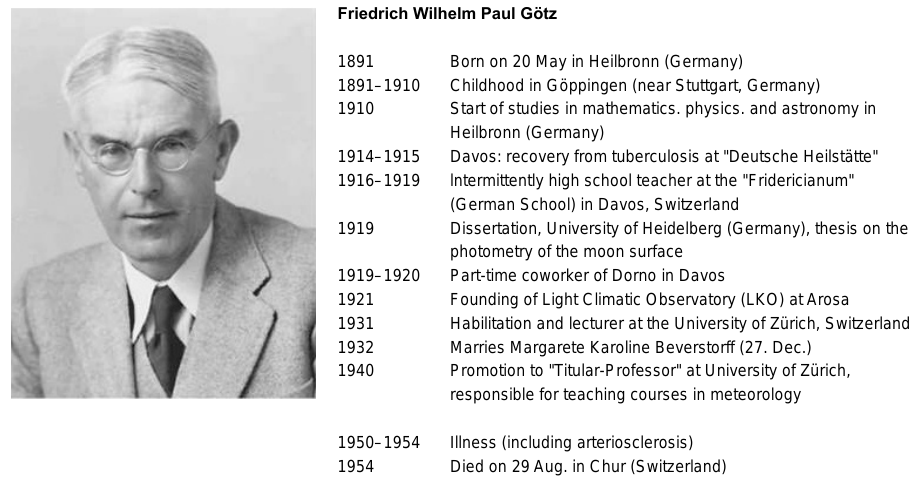
Figure 1. Biography of F. W. Paul Götz, founder of the Light Climatic Observatory in Arosa.